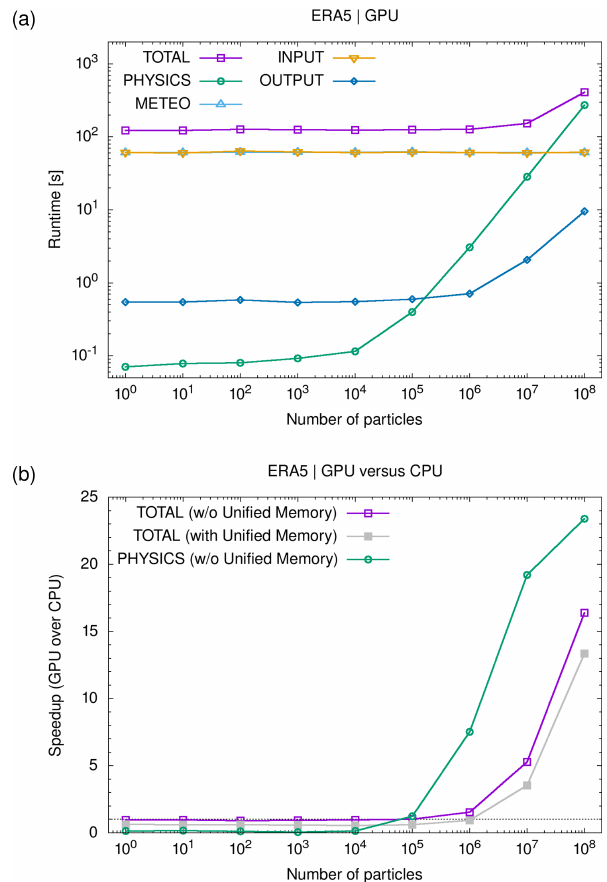
Figure 9. Scaling analysis showing (a) the runtime of MPTRAC simulations with respect to the number of particles on a JUWELS Booster GPU node and (b) the speed-up of GPU over CPU-only calculations. The simulations cover a 24h time period starting on 1 January 2017, 00:00UTC and used ERA5 input data. Colored curves in panel (a) refer to different parts of the code (see plot key). The speed-up of GPUs over CPUs shown in panel (b) was calculated for simulations with and without using NVIDIA’s Uni- fied Memory